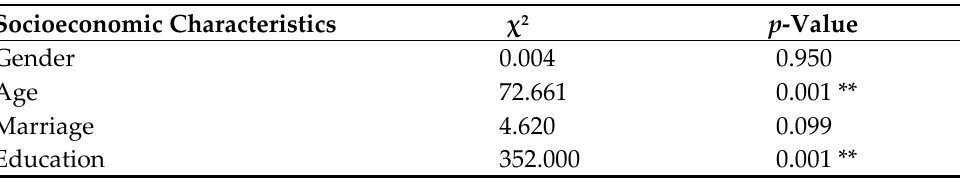
Table 2. Differences in the main socioeconomic characteristics between the survey respondents and Beijing residents based on the Chi-square test.